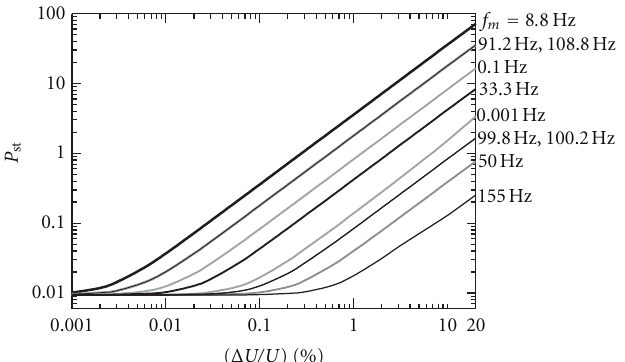
Figure 7: P st = f (( Δ U/U ), f m = var) characteristic for AM modulation with rectangular signal.